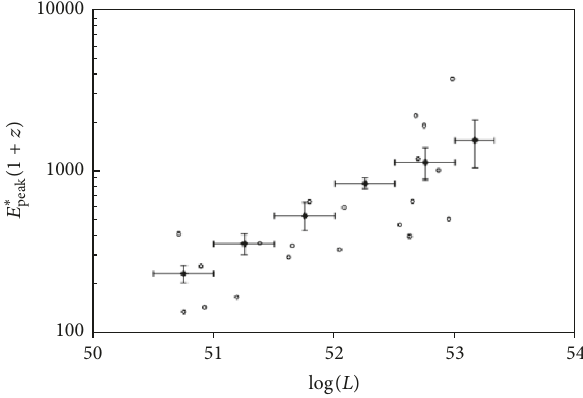
Figure 10: Direct fit of log 𝐿 -log 𝐸 data. This is shown here for iso peak two independent data sets for which the luminosities are derived by two independent methods. The first data set consists of 20 bursts with spectroscopically measured redshifts (the open circles). The second one is for 84 bursts (whose binned values are shown as filled diamonds, and the horizontal bars are the bin widths) whose luminosity (and then redshift) were determined with the spectral lag and variability light curve parameters. Both data sets show a highly significant and similar power law relations. (Figure after Schaefer [203]; see Figure 3 therein. @ AAS. Reproduced with permission.)